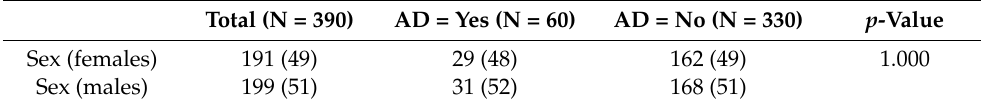
Table 1. Descriptive characteristics in the total population and stratified by AD